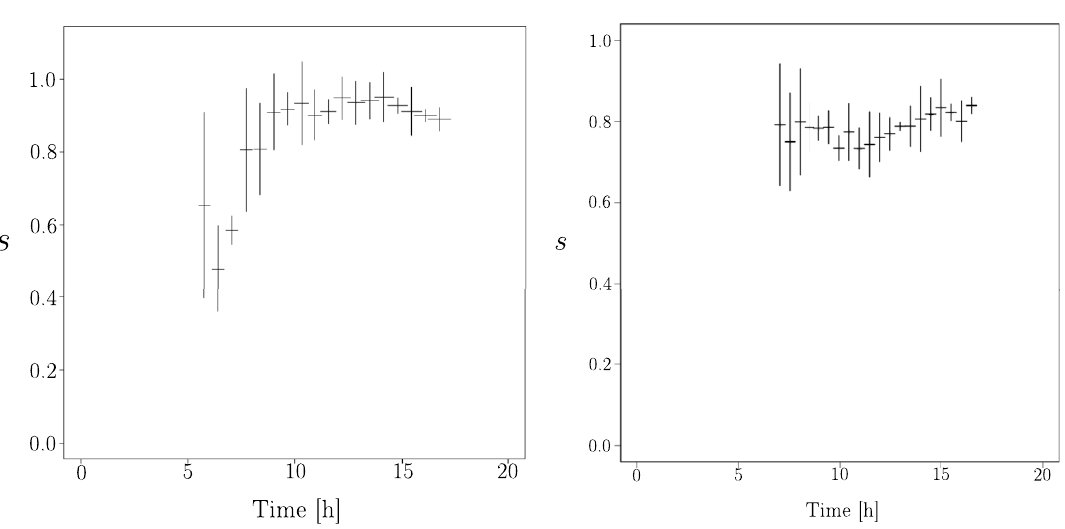
Figure 8. (Left) One standard deviation range of r sim points are r 1 extracted from the simulation with scaled time ans scaled space. (Right) One standard deviation data range of r 3 experimental data fit (grey). Black points are and space coming from V 1 ob . See text for details.